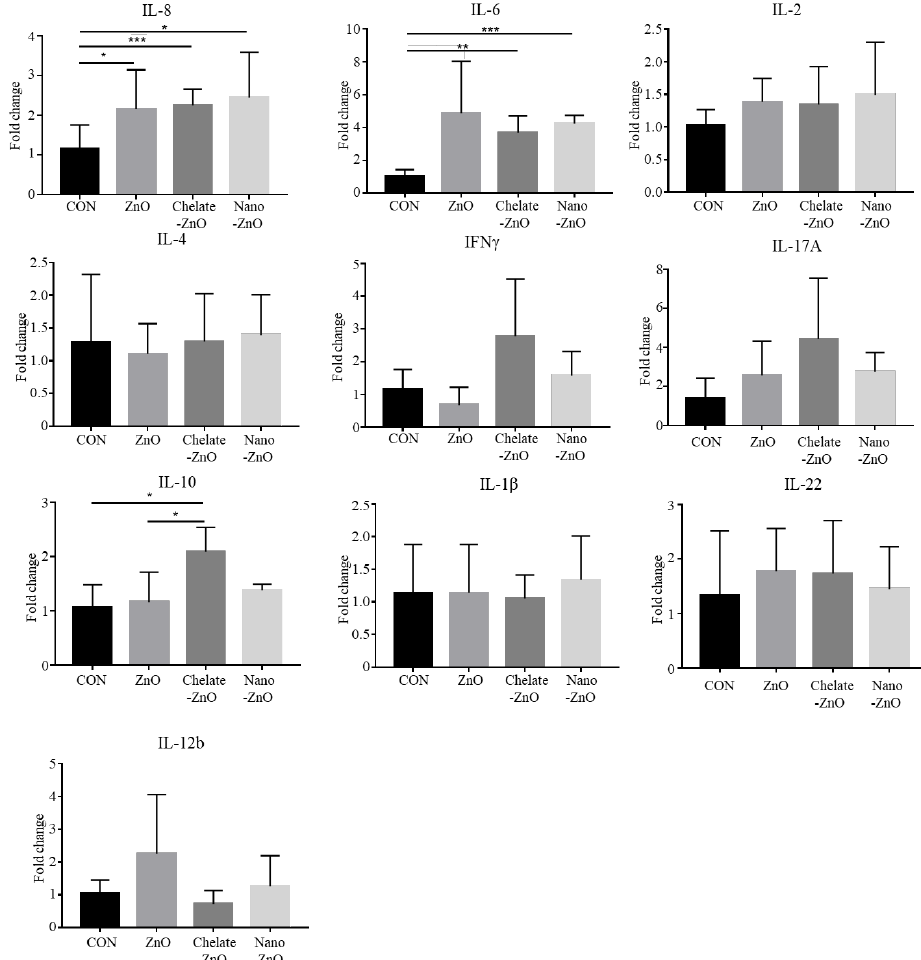
Figure 7. Cytokine expression in the colon tissues of weaned piglets fed different forms of zinc oxide. IL-8, IL-2, IL-4, IFN γ , IL-17A, IL-10, IL1â, IL-22, and IL-12b gene expression was examined using qRT-PCR in the colon tissues of weaning piglets that were administered different forms of dietary zinc oxide. mRNA expression levels of the cytokines in each group were calculated based on that of the negative control group (CON). All fold change values were normalized by GAPDH. Data are represented as mean ± SD. Values were statistically analyzed by one-way ANOVA with Tukey ’ s multiple comparison test. * p < 0.05; ** p < 0.005; *** p < 0.001.